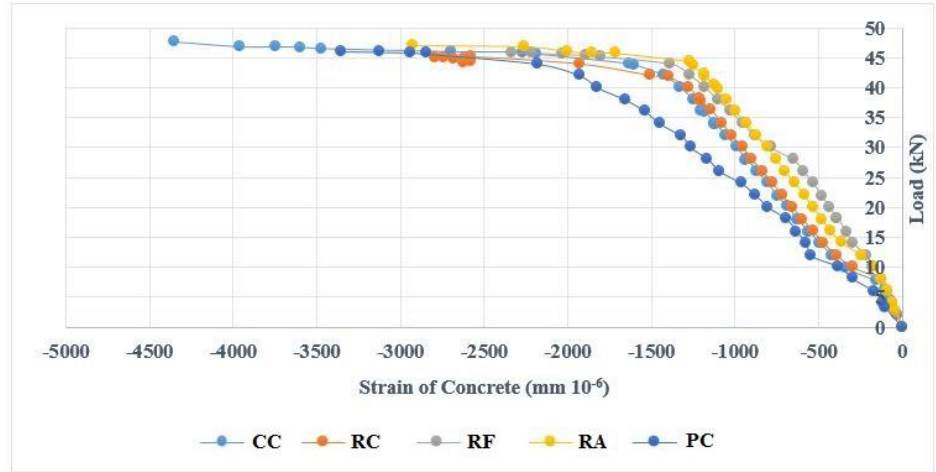
Figure 7. Load – strain curve of concrete in beam specimens. Figure 7. Load–strain curve of concrete in beam